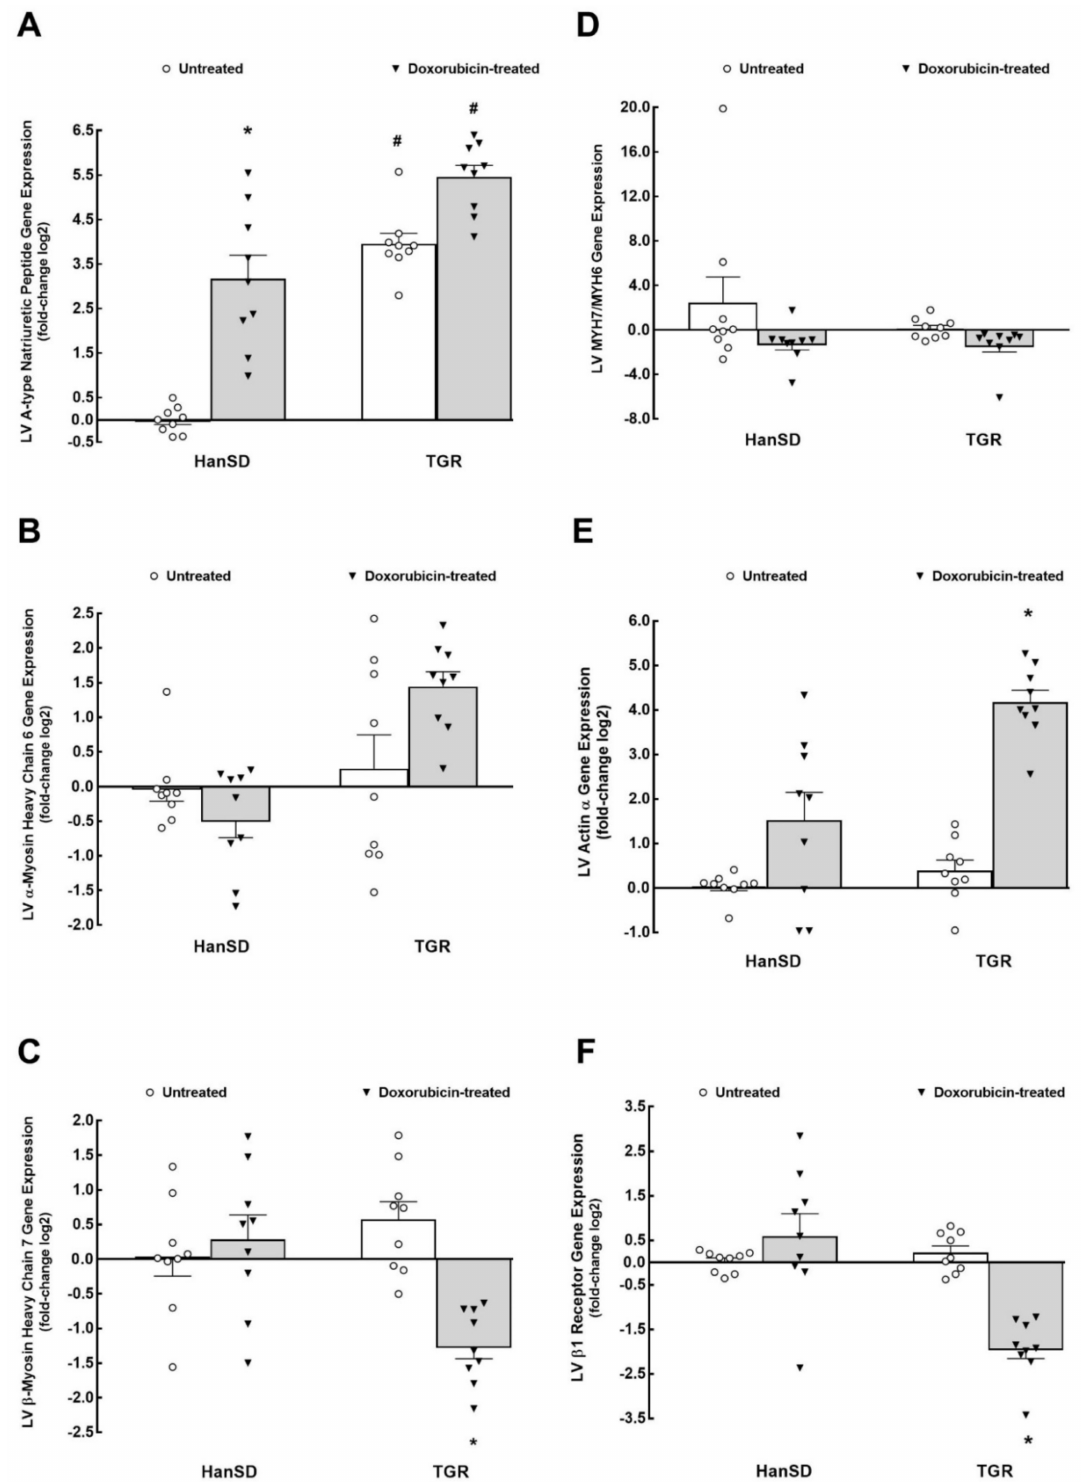
Figure 2. The first part of left ventricle (LV) mRNA expression. LV natriuretic peptide type A ( A ), α -myosin heavy chain isoform 6 ( MYH6 ) ( B ), β -myosin heavy chain isoform 7 ( MYH7 ) ( C ), ratio MYH7/MYH6 ( D ), α actin ( E ), β 1 adrenergic receptors ( F ) gene expression in untreated and doxorubicin-treated normotensive, transgene-negative Hannover Sprague– Dawley (HanSD) and hypertensive, Ren-2 transgenic (TGR) rats. * p < 0.05 compared with untreated animals of the same strain. # p < 0.05 versus HanSD rats within the same protocol. Statistical comparison was made by one-way ANOVA